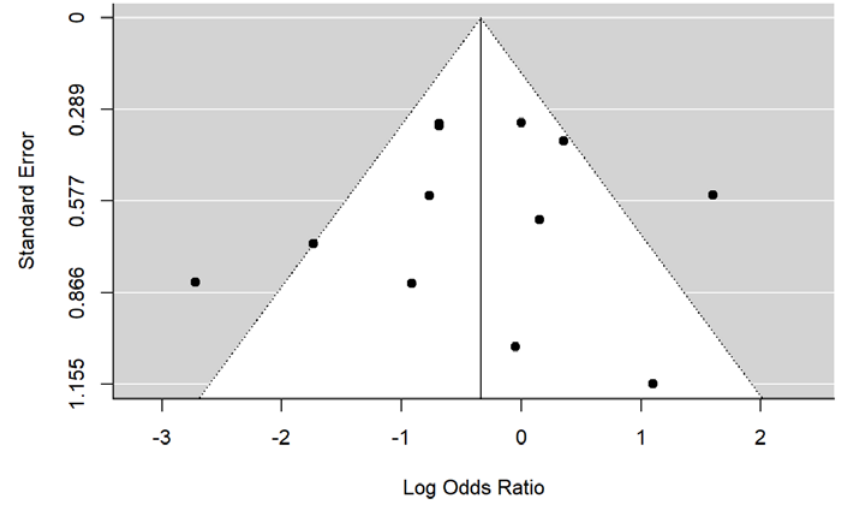
Figure 8. Funnel plot of publication bias.